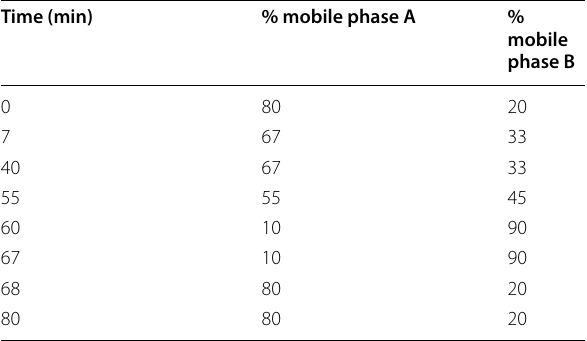
Table 2 HPLC method gradient